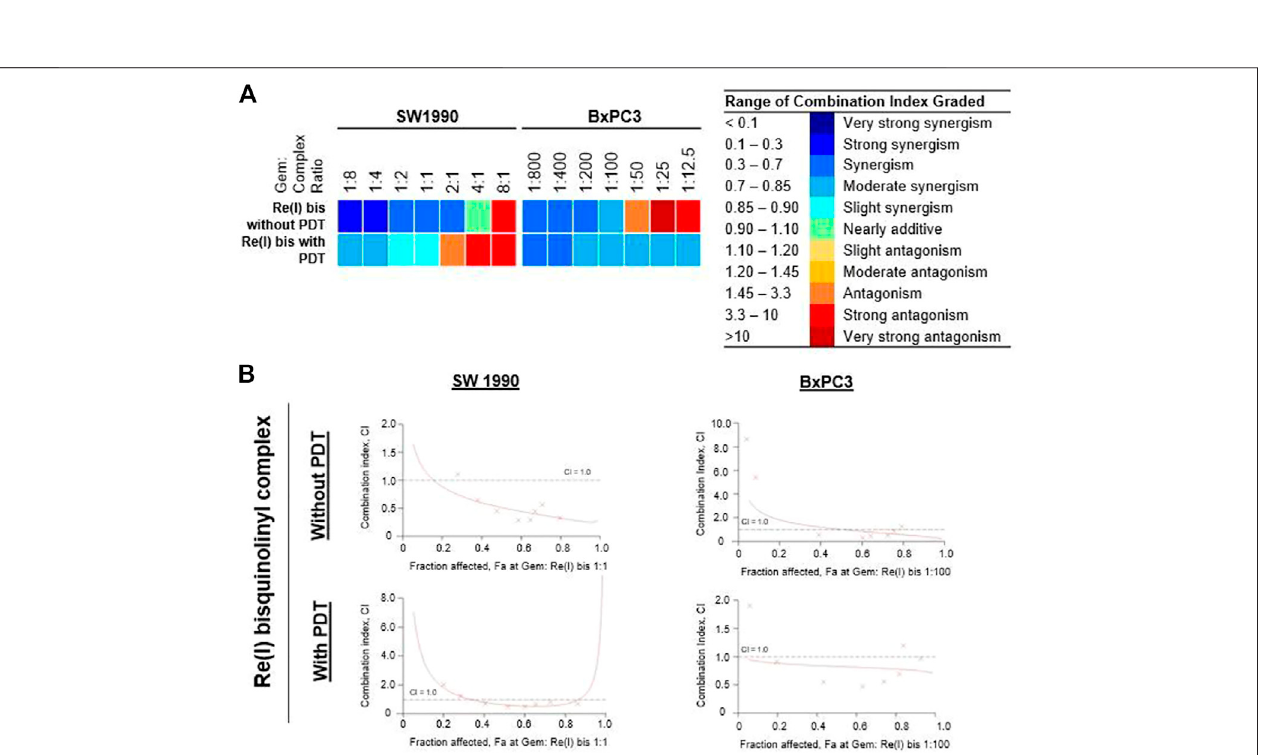
FIGURE3| Combinatory effectofgemcitabine withRe(I)bisquinolinylcomplexinpancreaticcancercells(Chou-Talalay). (A) Colourscalewasusedtovisualise the range for combination index (CI) in which blue meant synergism and red meant antagonism. (B) The fractional effect/CI curves reported the CI versus the fraction of SW1990/BxPC3 that were in fl uenced by the combinatorial treatment of gemcitabine and Re(I) bisquinolinyl complex at Gem:Re ratio as stated. The drug combinations displayed synergism when CI values were less than one.